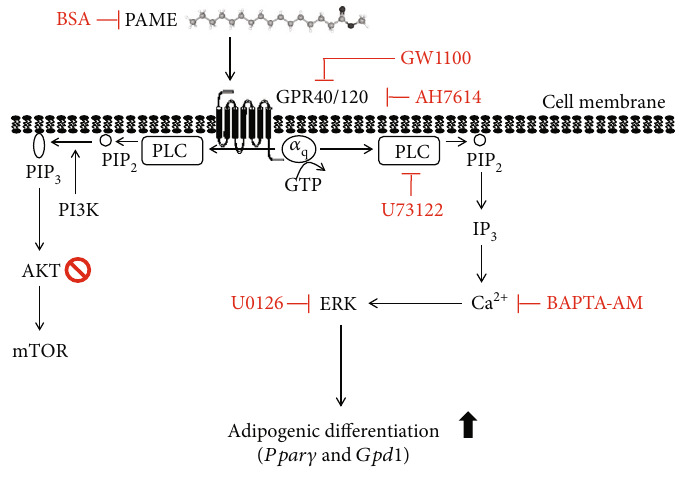
Figure 6: Schematic representation of the PAME-enhanced adipogenic di ff erentiation in rAD-MSCs. PAME stimulated the GPR40 and GPR120, subsequently activating PLC, which in turn caused IP generation, thereby leading to ERK1/2 activation through increases of 3 intracellular Ca 2+ levels, and eventually increased the expression of adipogenic di ff erentiation genes, Ppar γ and Gpd1